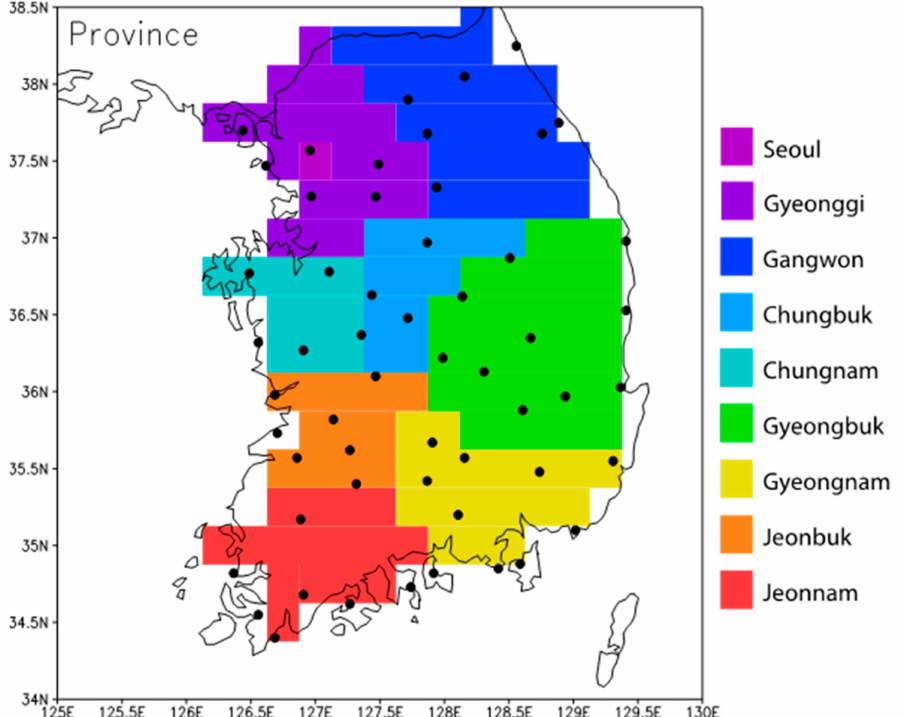
Figure 1. Fifty-five Korea Meteorological Administration (KMA) Automated Synoptic Observing System (ASOS) stations and provinces used for the classification of drought cases. The 0.25 ◦ resolution of the provinces indicates data originating from